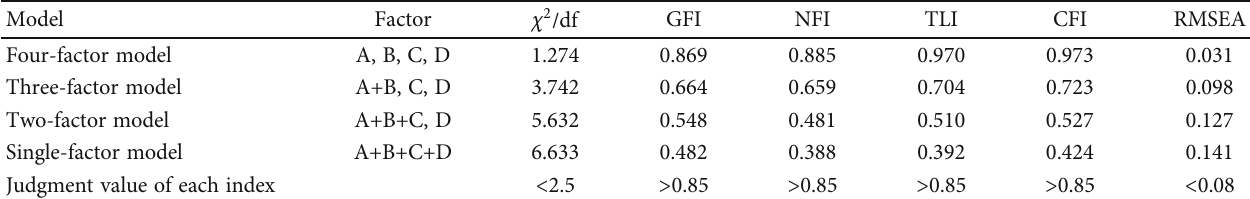
Table 1: CFA results.